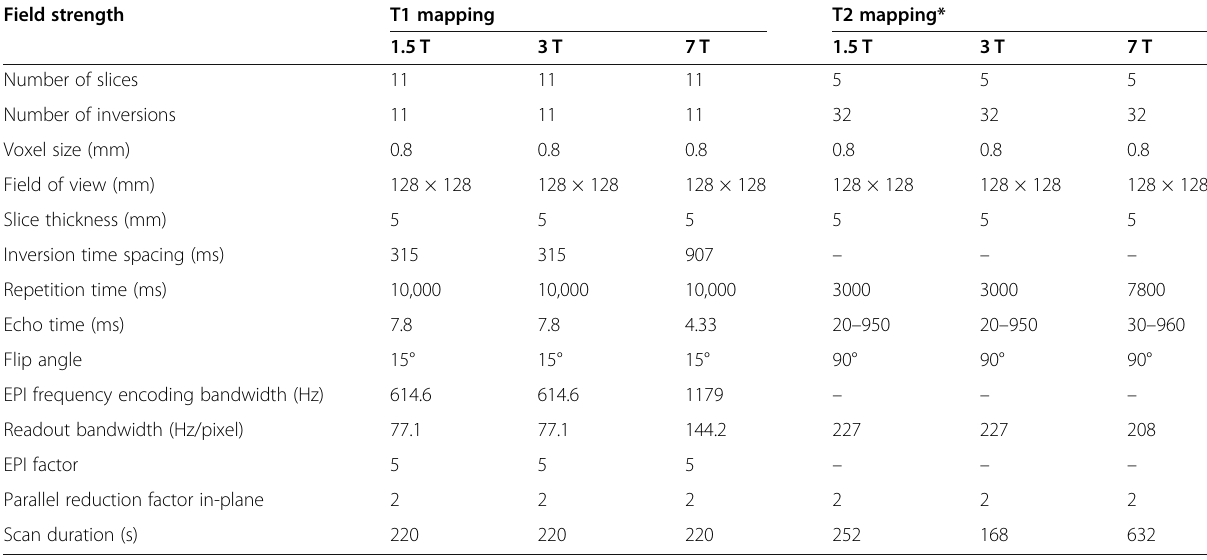
Table 1 MRI protocols for T1 mapping and T2 mapping with turbo spin-echo and sensitivity encoding acceleration, at 1.5, 3, and 7